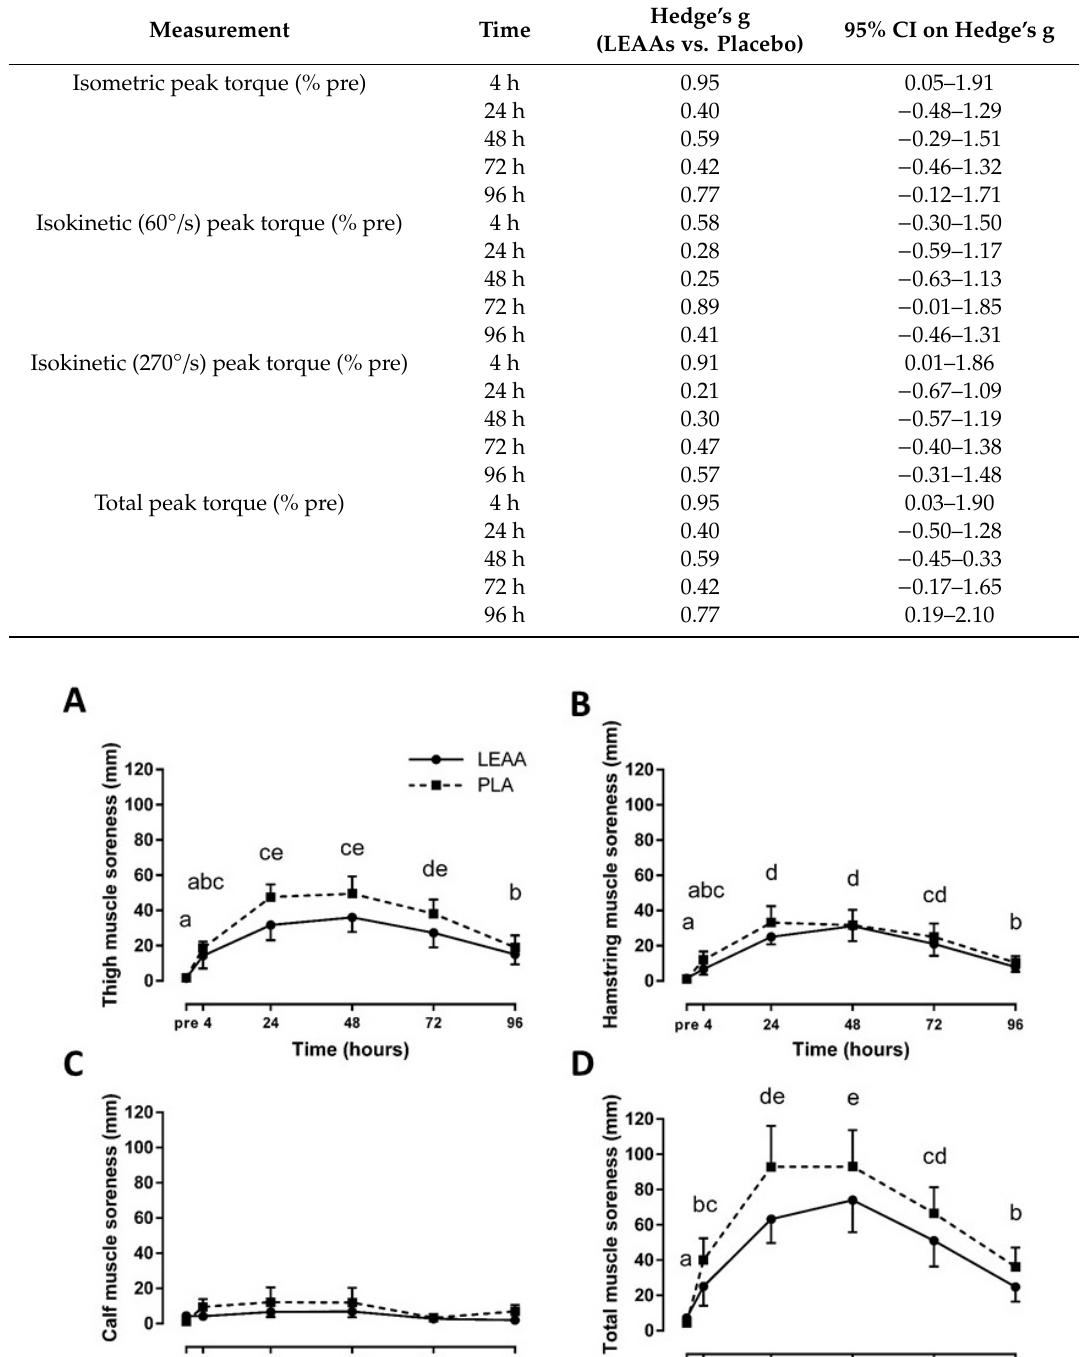
Table 2. E ff ect sizes and confidence intervals for isometric, slow isokinetic, fast isokinetic, and total peak torque after resistance exercise in response to LEAA versus placebo consumption. Thresholds for small, moderate, and large e ff ect sizes are 0.2, 0.5, and 0.8, respectively.